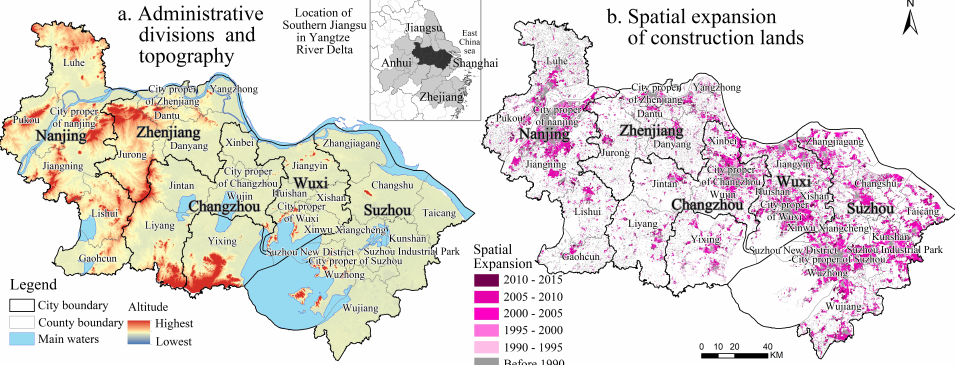
Figure 1. Administrative divisions, topography and expansion of construction lands in southern